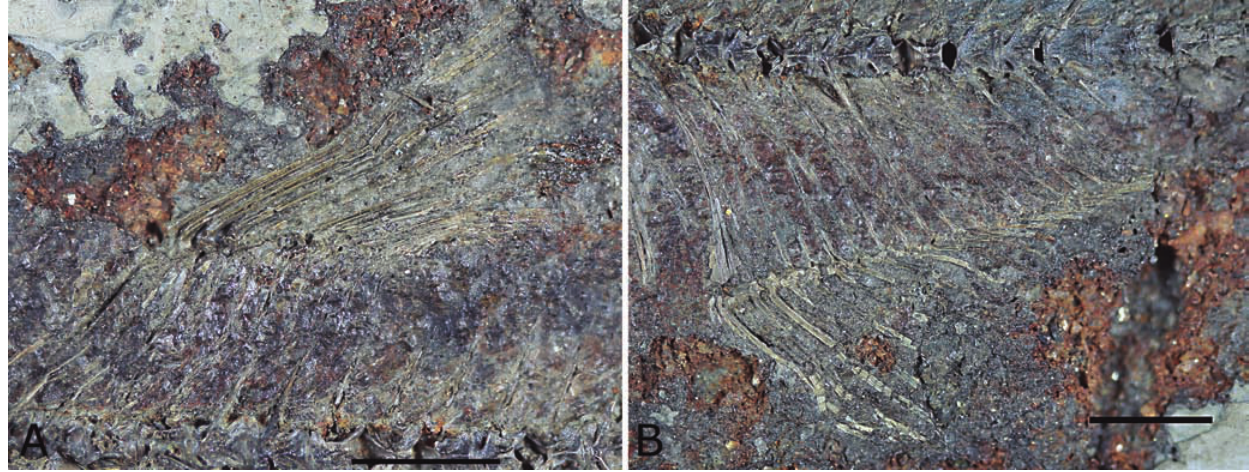
Fig. 5. † Bryconetes enigmaticus n. gen. n. sp., holotype, UFRGS 19114. A, dorsal fin. B, anal fin. Scale bars = 5 mm.